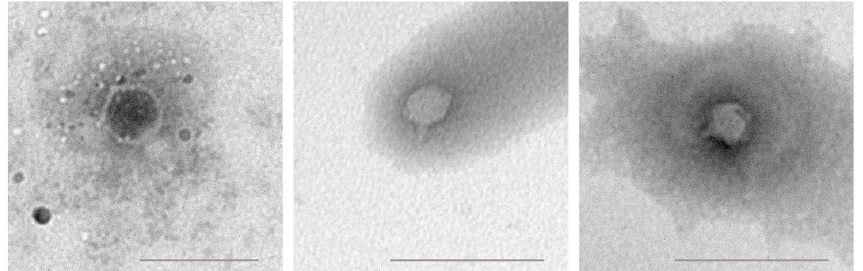
Figure 2. Virion morphology of vRsoP-WF2 ( left ), vRsoP-WM2 ( center ), and vRsoP-WR2 ( right ). Transmission electron micrographs of negatively stained R. solanacearum virions magnified at ×30,000 (vRsoP-WF2), and ×20,000 (vRsoP-WM2 and vRsoP-WR2). Scale bars represent 100 nm in vRsoP-WF2, and 200 nm in vRsoP-WM2 and vRsoP-WR2 micrographs, respectively.